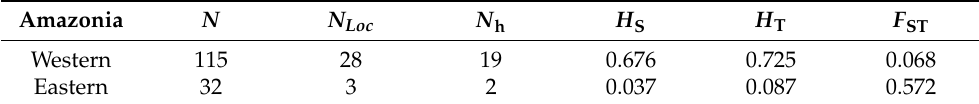
Table 2. Chloroplast haplotype diversity within cacao populations in western and eastern Amazonia. Amazonia N N Loc N h H S H T Western